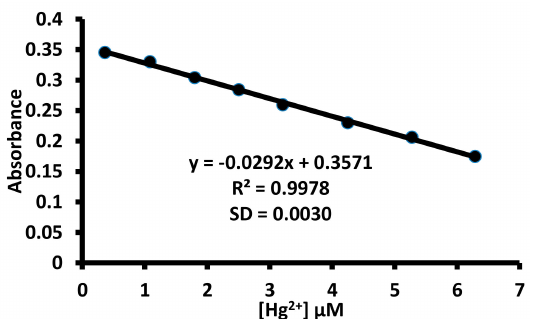
Figure 15. The determination of limit of the detection value of 1 towards mercuric ions using ultra violet (UV)-Visible spectroscopy.